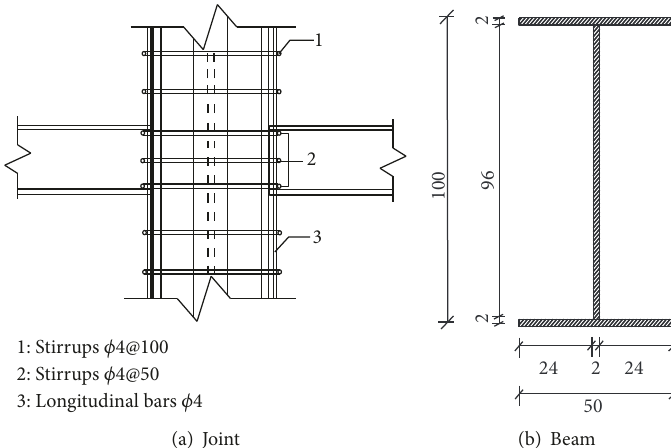
Figure 3: Details of joint and beam (units: mm).